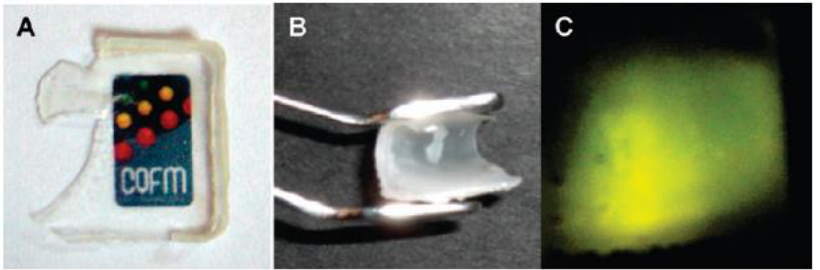
Figure 10. Hybrid film showing transparency ( A ), flexibility ( B ), and strong fluorescence emission under excitation at λ exc = 450 nm ( C ). Reprinted with permission from ref. [88]. Copyright 2009 ACS.